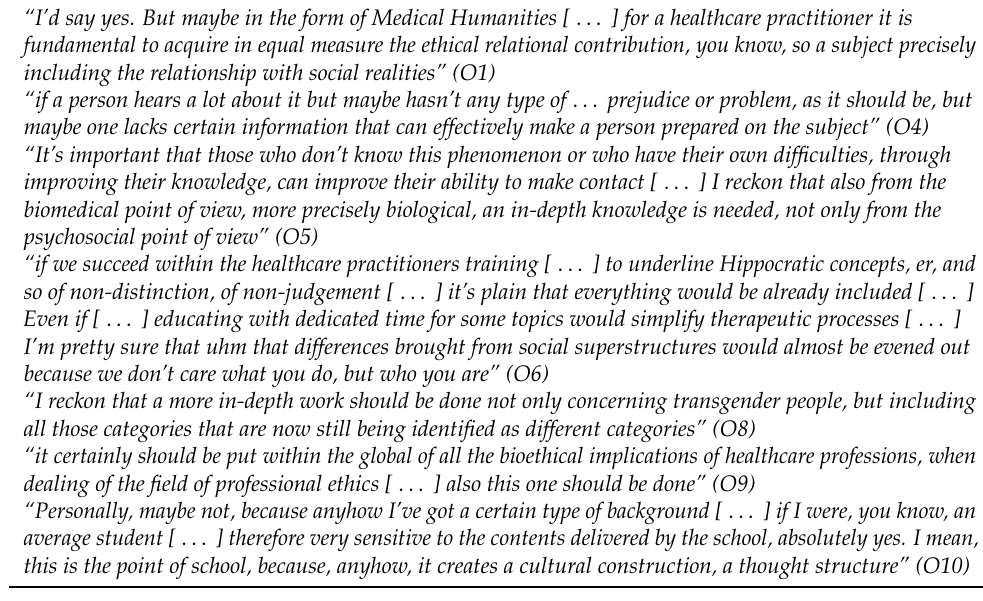
Table 14. Need to implement the educational